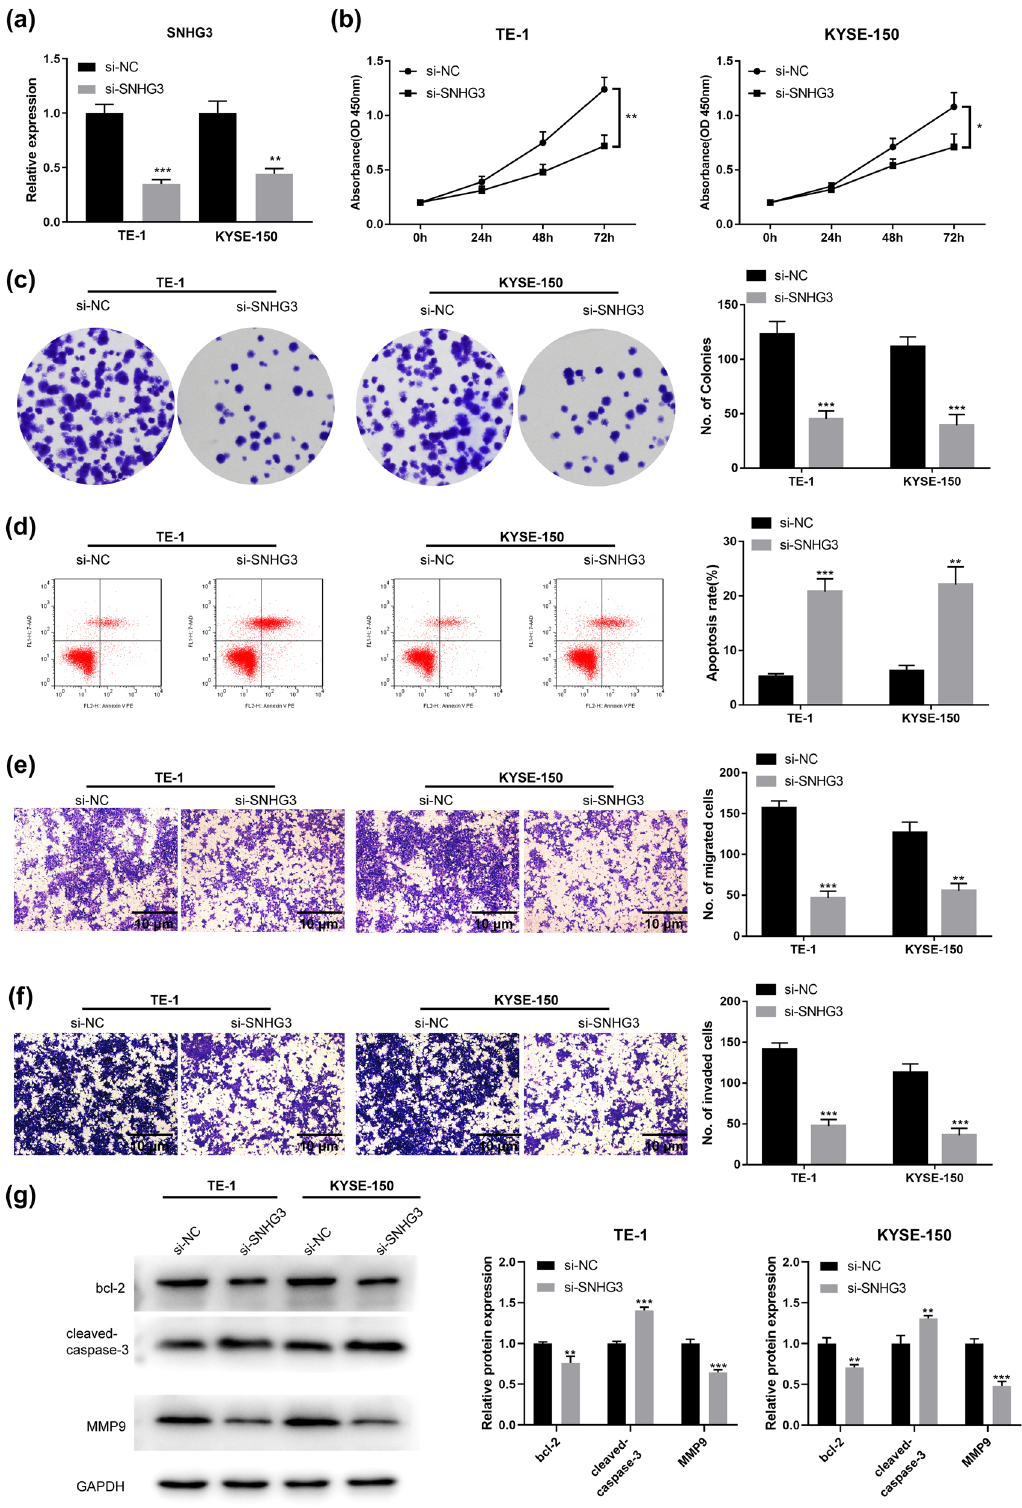
Figure 2: lncRNA SNHG3 knockdown inhibited cell proliferation, migration, and metastasis. TE - 1 and KYSE - 150 cells were transfected with si - SNHG3 or si - NC. ( a ) The expression of SNHG3 in TE - 1 and KYSE - 150 cells were examined. ( b ) CCK - 8 assay was performed for cell prolif - eration. ( c ) Colony formation assay was employed to analyze cell colony formation ability. ( d ) Flow cytometry was performed to evaluate cell apoptosis. ( e and f ) Transwell assay was carried out for cell migration ( e ) and invasion ( f ) , scale bar = 10 μ m. ( g ) Western blot assay was conducted to analyze the protein levels of bcl - 2, cleaved - capsase - 3, and MMP9. ** P < 0.01, *** P <